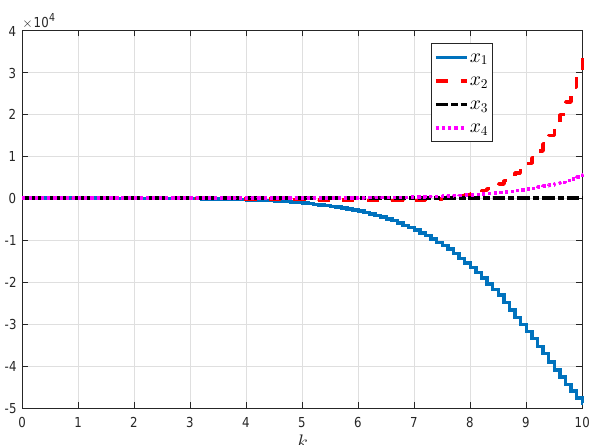
Figure 8. State trajectories in case